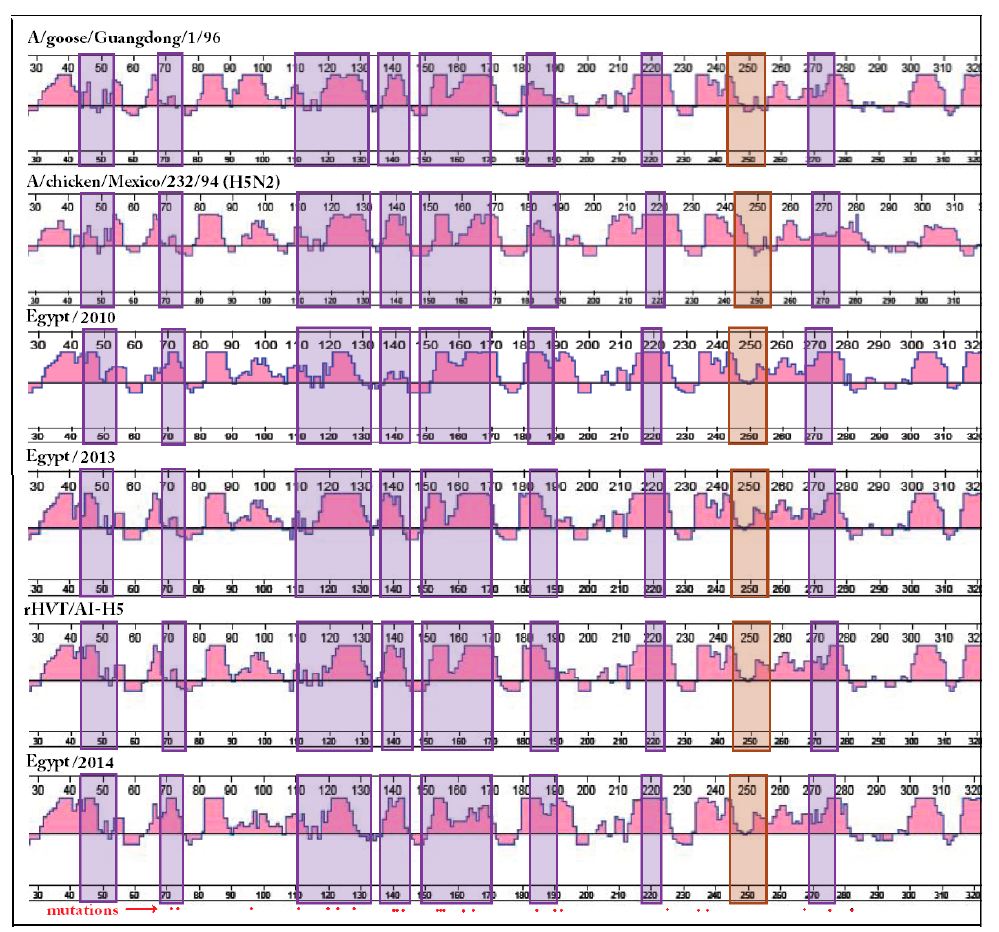
Figure 1. The antigenic index of avian influenza virus hemagglutinin subunit 1 (AIV HA1) protein sequences. The antigenic index was calculated and plotted using Protean™ (DNA Star, Lasergene ® , version 7.1.0, DNAStar Inc., Madison, WI, USA). The antigenic index was used because of its relevance to vaccine design and evaluation. Sequence elements involved in vulnerable sites (VS) formation [17] were highlighted using violet boxes. The linear epitope sequences [28] were highlighted using a light brown colored box. The H5 numbering system was used. Red dots below indicate amino acid differences between the vaccine seed and field viruses in Case C (Section 3.1). The antigenic index was affected with mutations inside VS in a manner that was not always related to the number of mutated amino acids. Amino acid changes outside VS (Figure S1) that were also associated with changes in hydrophilicity and/or charge had a dramatic effect on adjacent VS.